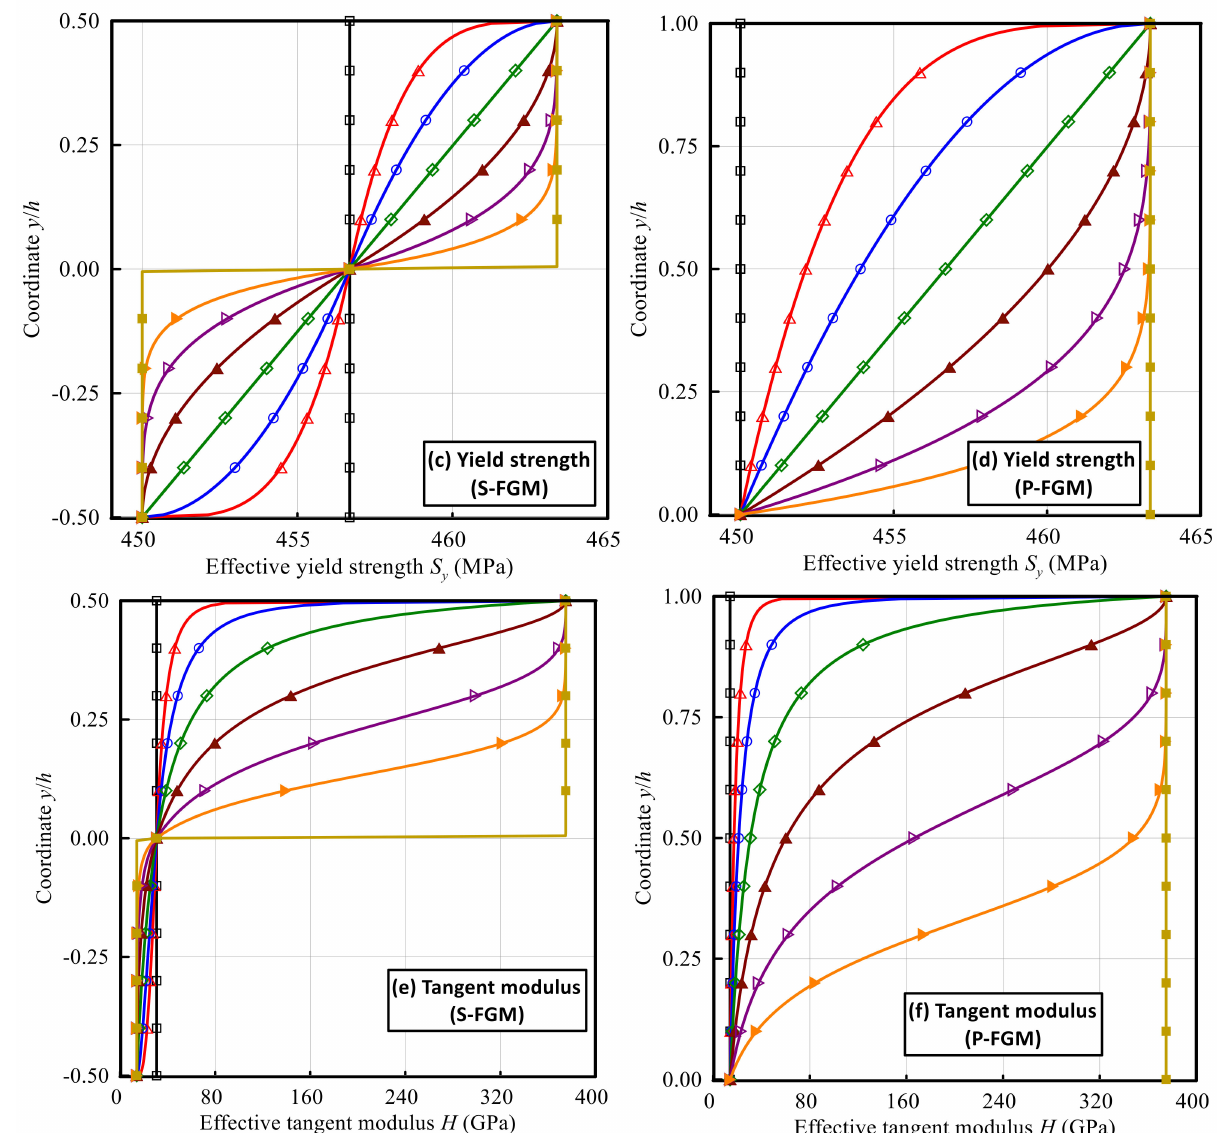
Figure 2. Variation in modulus of elasticity, yield strength, and the tangent modulus of the elastoplas- tic FGM Ti/TiB specimen along the thickness direction for the sigmoid function (S-FGM) and power law function (P-FGM). ( a ) Variation in modulus of elasticity of S-FGM, ( b ) Variation in modulus of elasticity of P-FGM, ( c ) Variation in yield strength of S-FGM, ( d ) Variation in yield strength of P-FGM, ( e ) Variation in tangent modulus of S-FGM, ( f ) Variation in tangent modulus of